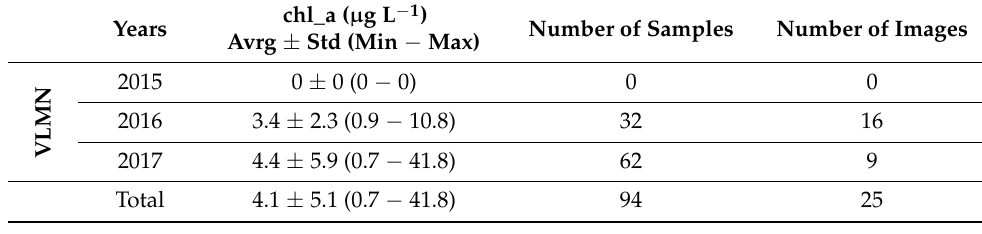
Table 2. A summary of the chlorophyll-a (chl_a) measurements sampled by the Voluntary lakes monitoring network (VLMN) during the years 2015 to 2017 and the number of cross-over images. Avrg, Std, Min, and Max refer to average, standard deviation, minimum, and maximum values, respectively.